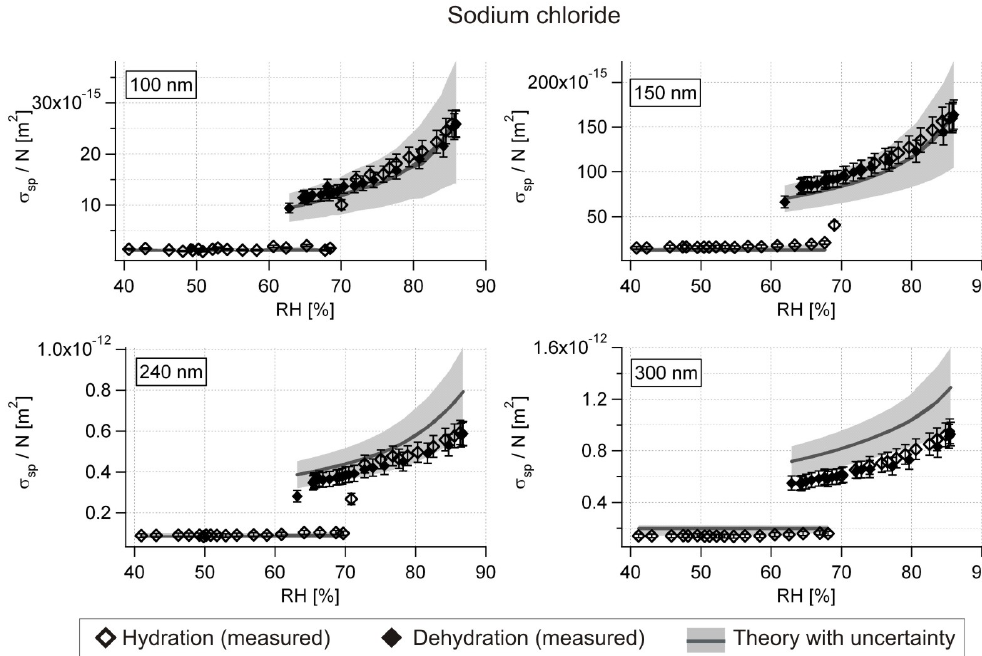
Fig. A3. Scattering coefficient normalized by the number concentration vs. RH in the nephelometer of quasi monodisperse sodium chloride particles with diameters between 100 and 300nm. The grey lines represent the predicted values, with their corresponding uncertainties. The black open diamonds show the measured σ sp /N while hydrating, whereas the black closed diamonds illustrate the corresponding dehydration values. The black error bars illustrate the measurement uncertainty of the nephelometer.